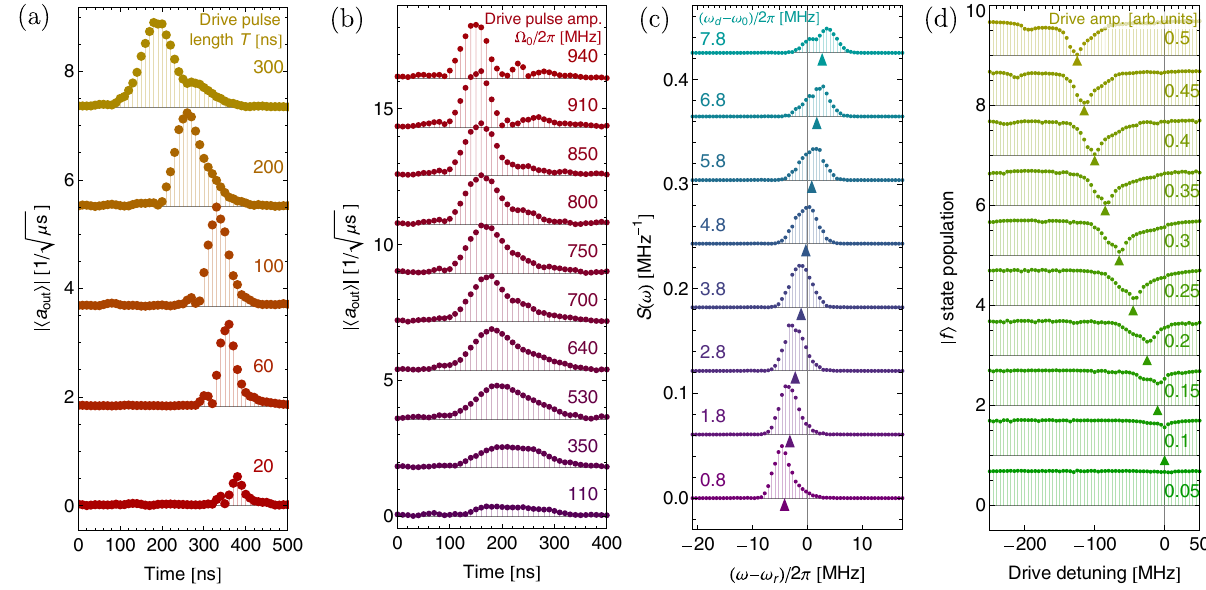
ffiffiffi p 2 for the indicated length of the drive pulse þ α − ω . The triangle marks the q r